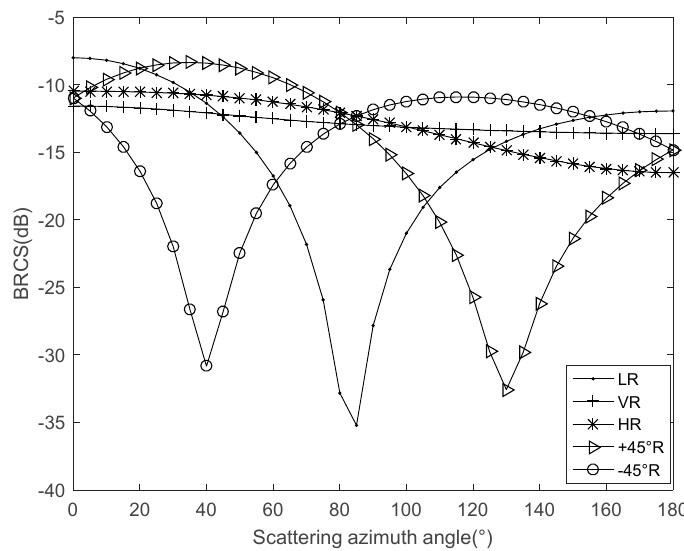
Figure 7. Scattering azimuth angles’ effects on BRCS at five different polarizations.